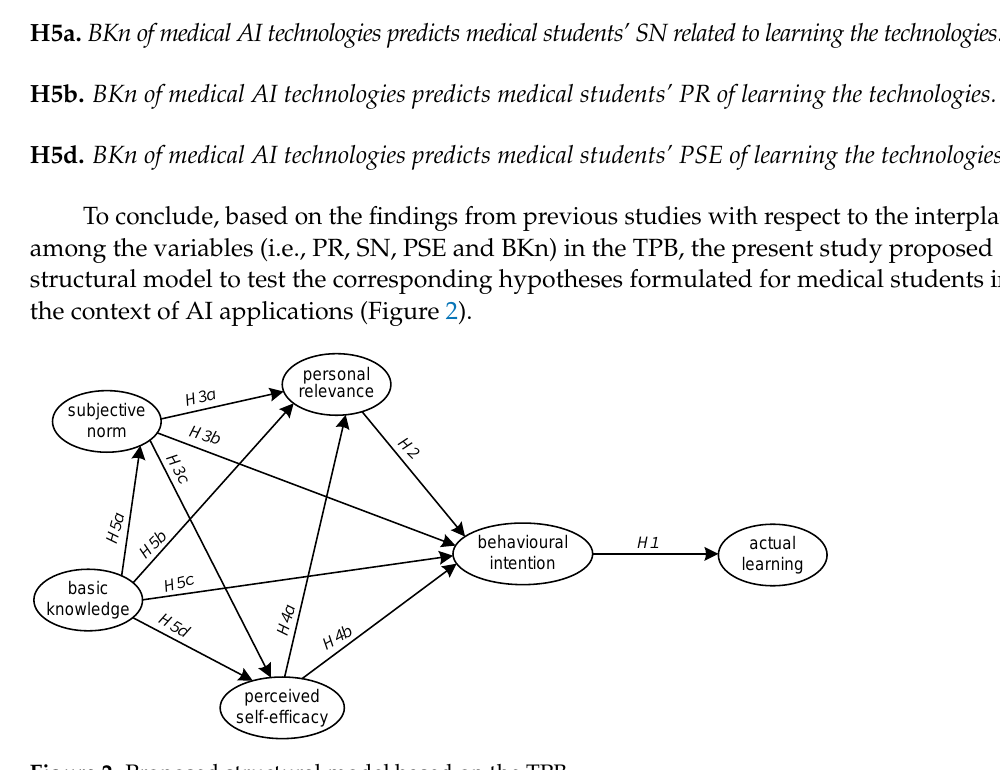
Figure 2. Proposed structural model based on the